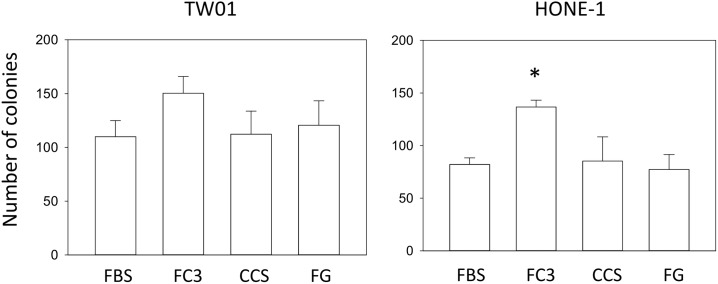
Anchorage-independent growth of cells cultured in alternative sera.Soft-agar colony formation assays were performed in TW01 and HONE-1 cells. Colony numbers were counted after three weeks of growth. Data indicate the average value of triplicates (mean ± SD). *:p = 0.004 compared with cells cultured in FBS.